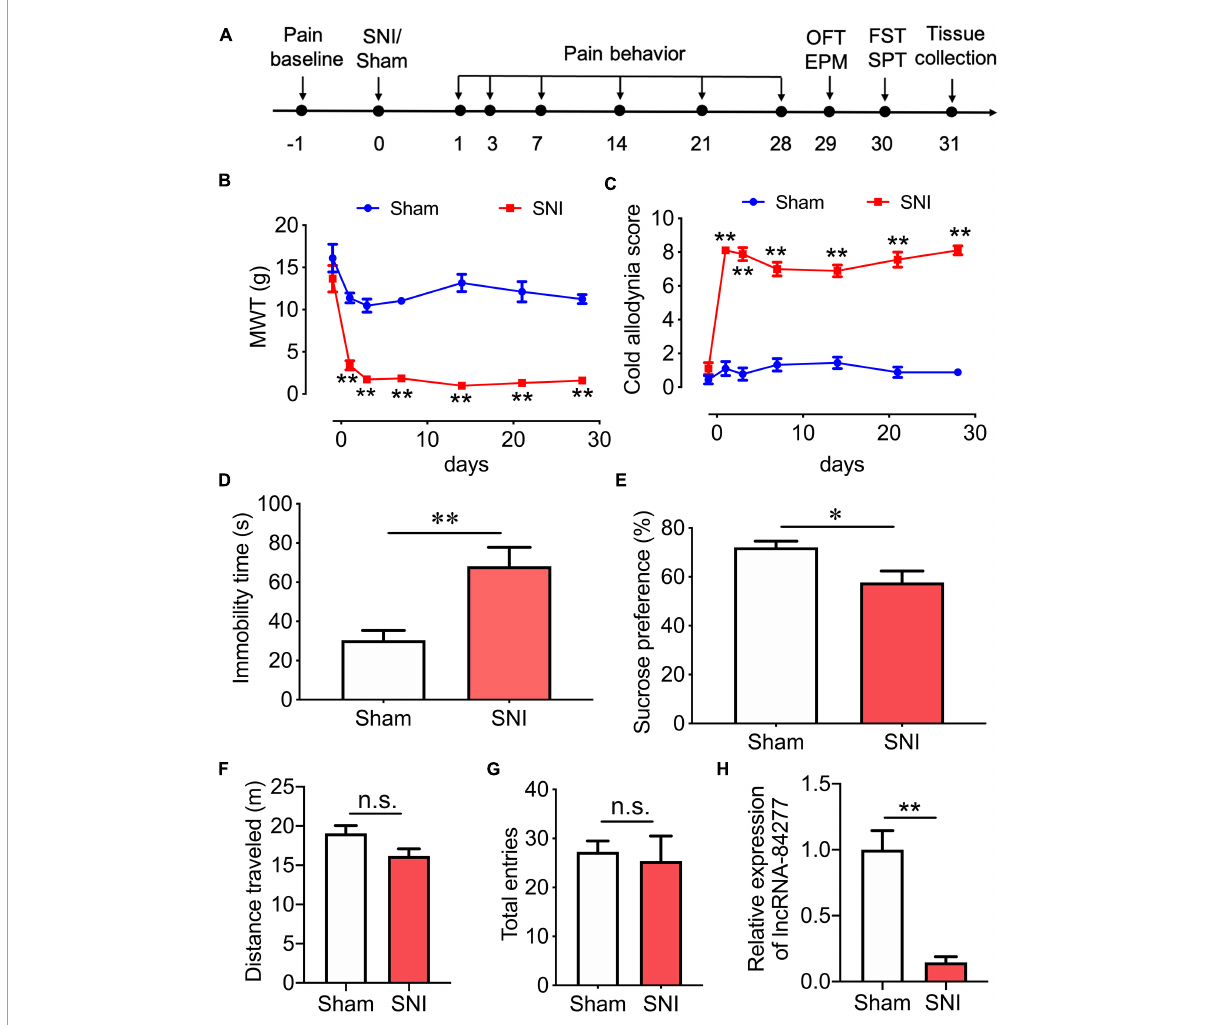
FIGURE1 LncRNA-84277 is downregulated in CeA of SNI-induced depression rats. (A) Experimental timeline. (B,C) Sensory pain was assessed by the mechanical withdrawal threshold (MWT) for mechanical allodynia (B) and the cold allodynia score for cold allodynia (C) ( n = 9). (D,E) Depression-like behaviors were assessed by the immobility time in the forced swim test (D) and sucrose consumption in the sucrose preference test (E) ( n = 8). (F,G) Locomotor activity was assessed by the total distance traveled in the open field test (F) and the total entries to open arms and closed arms in the elevated plus-maze test (G) ( n = 8). (H) The mRNA expression of lncRNA-84277 in the CeA of rats was determined by RT-qPCR ( n = 8). All data are expressed as the mean ± SEM. ∗ P < 0.05, ∗∗ P < 0.01. n.s., not significant. OFT, open field test; EPM, elevated plus-maze test; FST, forced swim test; SPT, sucrose preference